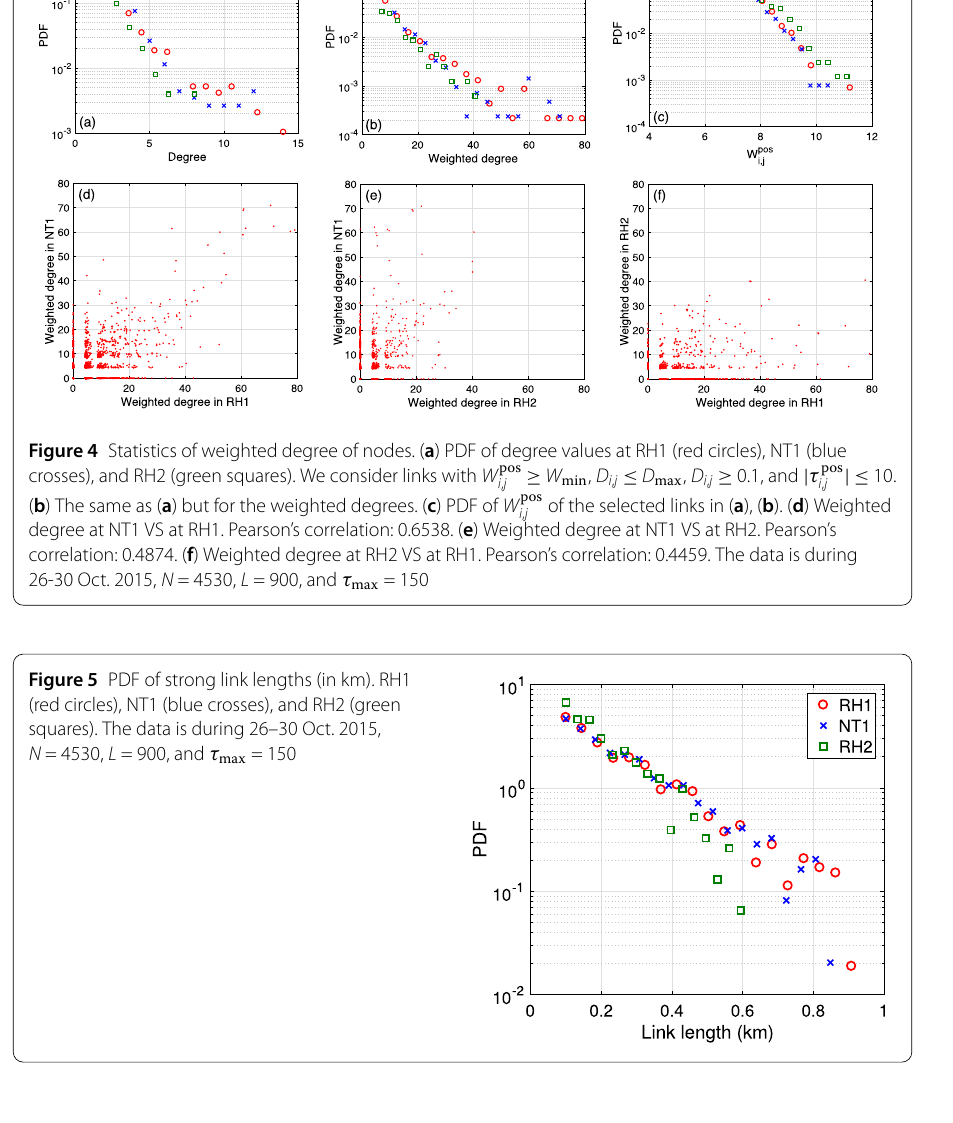
RH1 (green segments) and 227 nodes in NT1 (yellow segments) are shown in Fig. 6(a), (b), where red segments are those 90 overlapping nodes. Notice that the percentages of the overlapping nodes among the selected hub nodes in RH1 and NT1 are 40.36 % and 39.65 % , respectively. Figures 6(c) further shows the 116 nodes with the largest weighted degrees in RH2 (yellow segments), where red segments describe 56 overlapping nodes with RH1 (48.28 % of the 116 hub nodes in RH2). According to Fig. 6(a), major hub nodes in RH1 include “Fuxingmen Inner St. (east to west)”, “N. 4th Ring Rd. W. (east to west)”, “S. 3rd Ring Rd. W. (east to west)”, “E. 3rd Ring Rd. Middle (north to south)”, and “E. 4th Ring Rd. S. (north to south)”. In NT1, “Xitucheng Rd. (south to north)”, “Lianhuachi E. Rd. (east to west)”, and “Landianchang S. Rd. (north to south)” are the major hub nodes. Finally, in RH2, “Lianhuaqiao (west to east)” and “W. 3rd Ring Rd. N. (both directions)” become the major hub nodes. Notice that some of these roads correspond to locations with